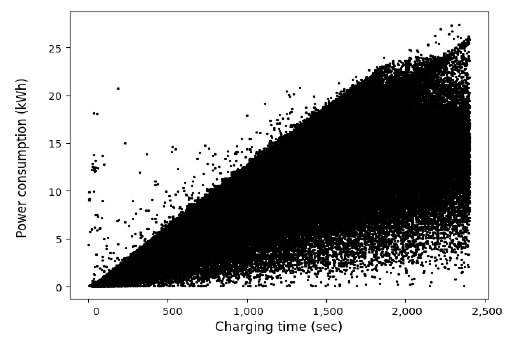
Figure 2. Actual electric power consumption distribution of a fast charger according to charging time (units: charging time (sec), power consumption